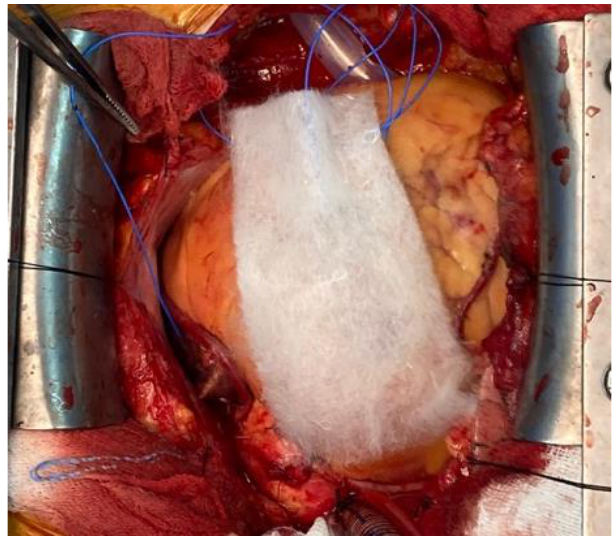
Figure 4. Intraoperative aspect of Fibrilar oxidised cellulose.